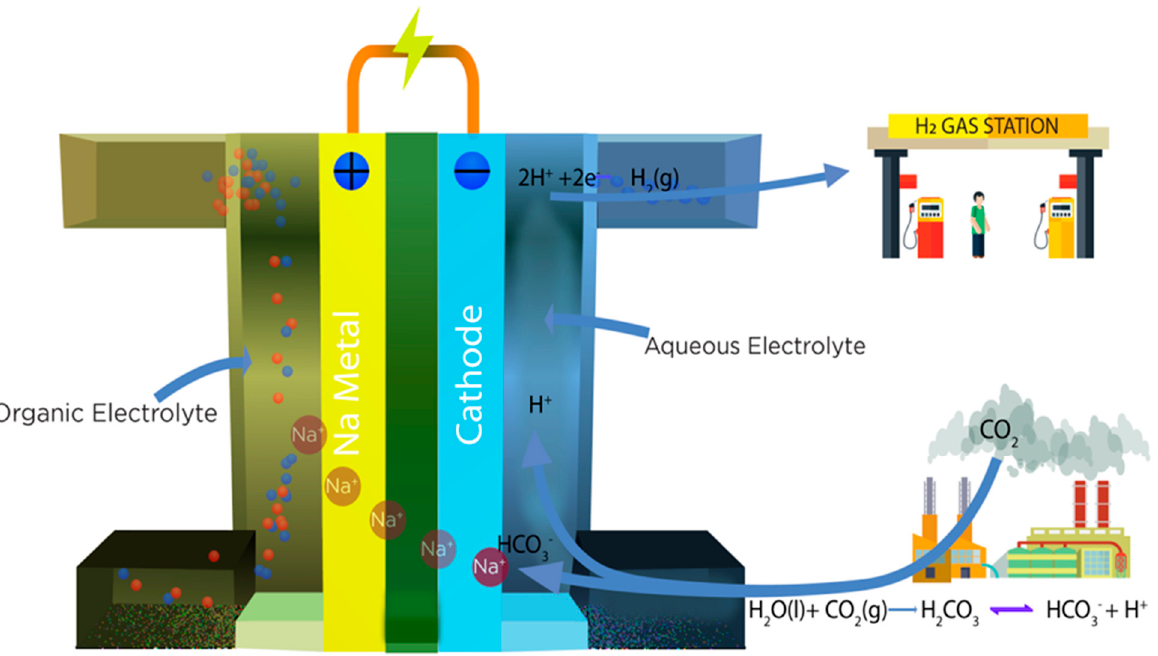
Figure 5. The figure is a representation for the Na-CO 2 system and its pathway of reaction.